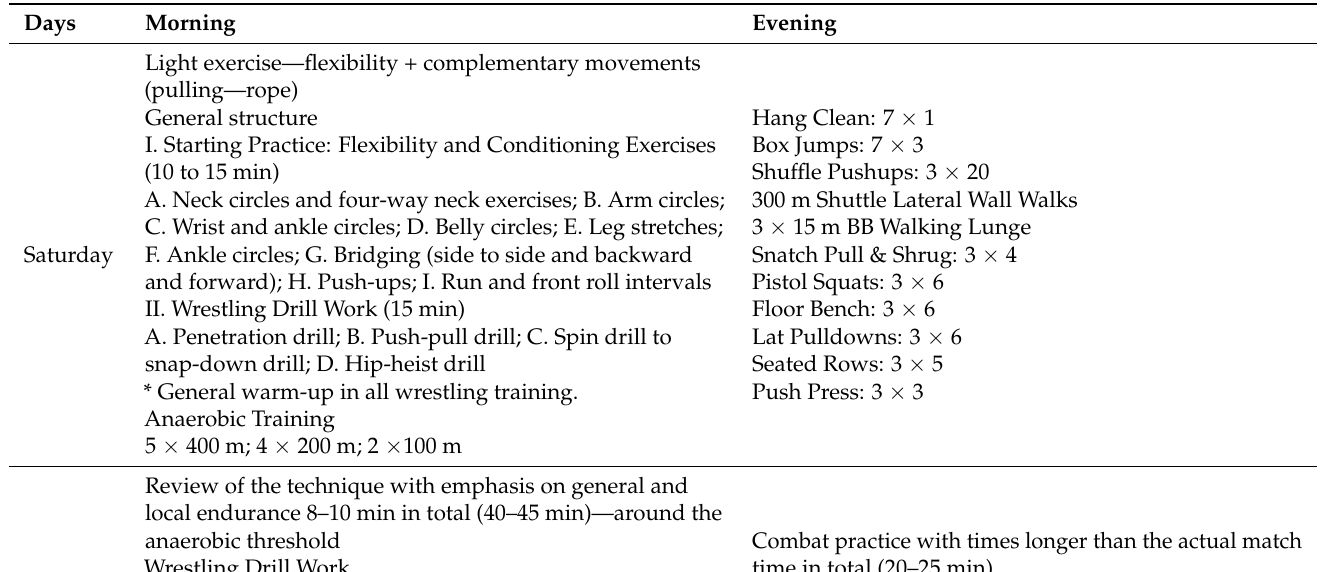
Table 3. Design of a microcycle in the mid of the preparation